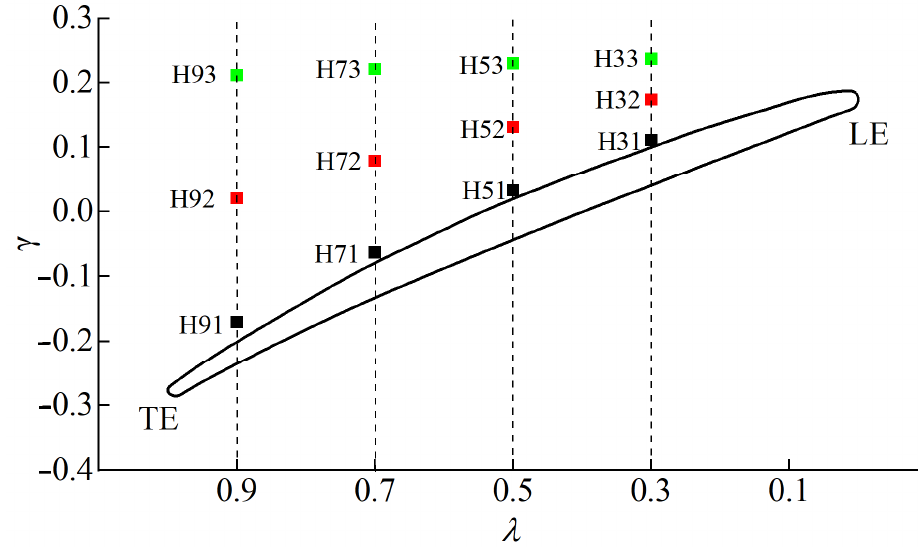
Figure 19. Schematic diagram of pressure pulsation monitoring points’ setting positions (r* = 0.98).